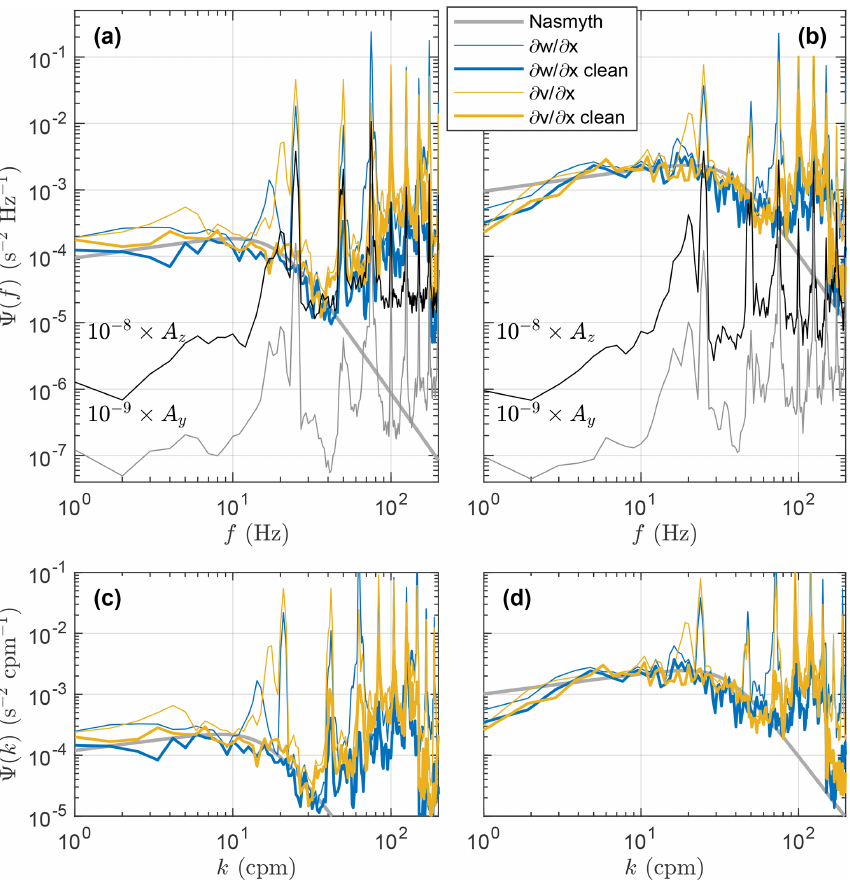
Figure 5. Example frequency spectra with (a) moderate ( ε = 5 . 7 × 10 − 8 Wkg − 1 ) and (b) high ( ε = 1 . 4 × 10 − 6 Wkg − 1 ) dissipation rates using 8s long records. Vibration spectra along the instrument’s main and transverse axes are also shown with an offset as indicated. Cleaned spectra as indicated by the legend show frequency spectra after removing the shear probe signal coherent with the accelerometer signal. Empirical Nasmyth spectra are shown for the values of ε . Panels (c) and (d) show the same shear spectra as (a) and (b) , respectively, but in the wavenumber domain. ∂w/∂x and ∂v/∂x are shear probes 1 and 2, respectively, on the